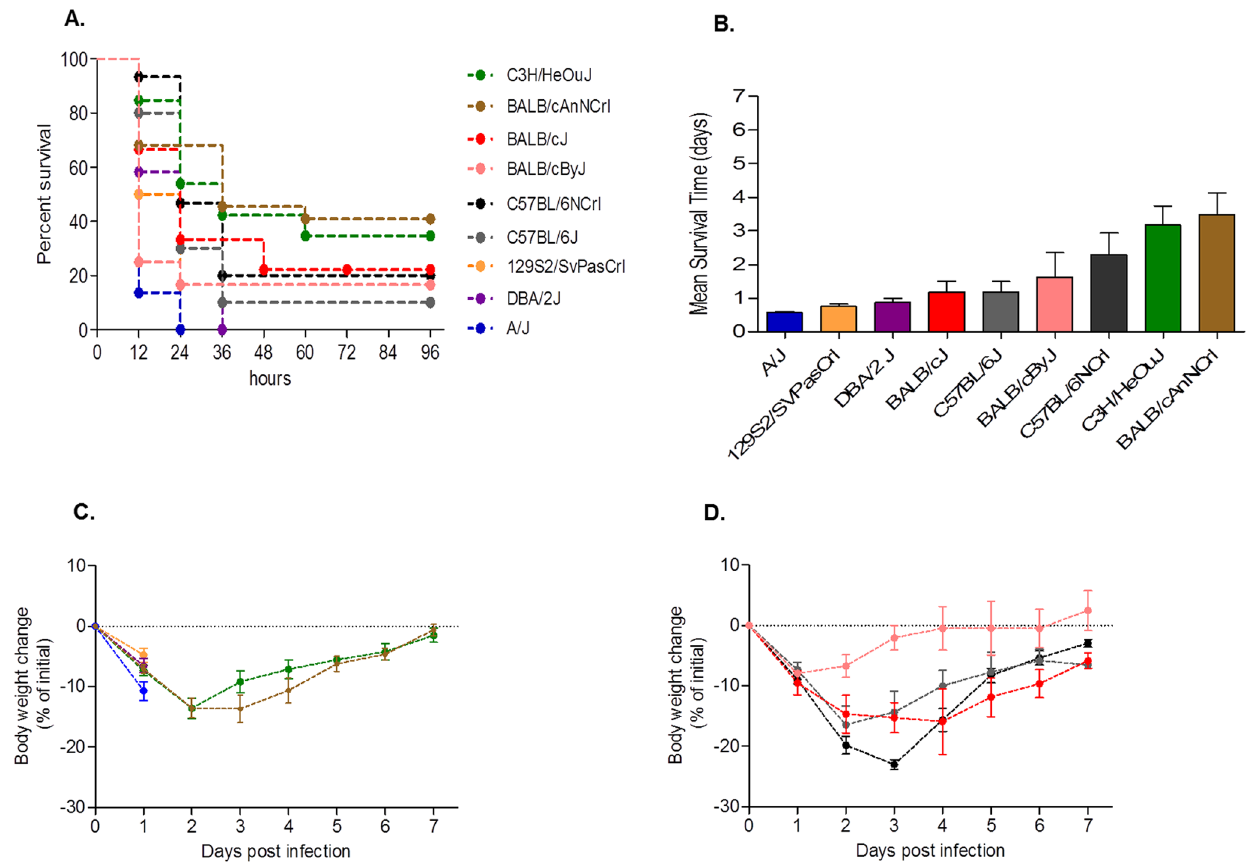
Figure 1. Survival, body weight and mean survival time after P.aeruginosa infection in inbred mouse strains. A/J (n=22), BALB/cJ (n=9), BALB/cAnNCrl (n=8), BALB/cByJ (n=12), C3H/HeOuJ (n=26), C57BL/6J (n=10), C57BL/6NCrl (n=15), DBA/2J (n=12), and 129S2/SvPasCRL (n=12) mice were inoculated with 5 6 10 6 CFU of P. aeruginosa clinical isolate AA2, and monitored for survival ( A ) and weight change for a period of seven days after infection ( C, D ). In addition, mean survival time was calculated based on the survival curve ( B ). Bar represent mean values and the error bars the standard error of the mean (SEM). The data are pooled from two to four independent experiments. Statistical significance by Mantel- Cox test for survival ( A ), One- way ANOVA with Bonferroni’s Multiple comparison test ( B ) for mean survival time and Two-way ANOVA with Bonferroni’s Multiple comparison test ( C, D ) is reported in Table S1–S3 .